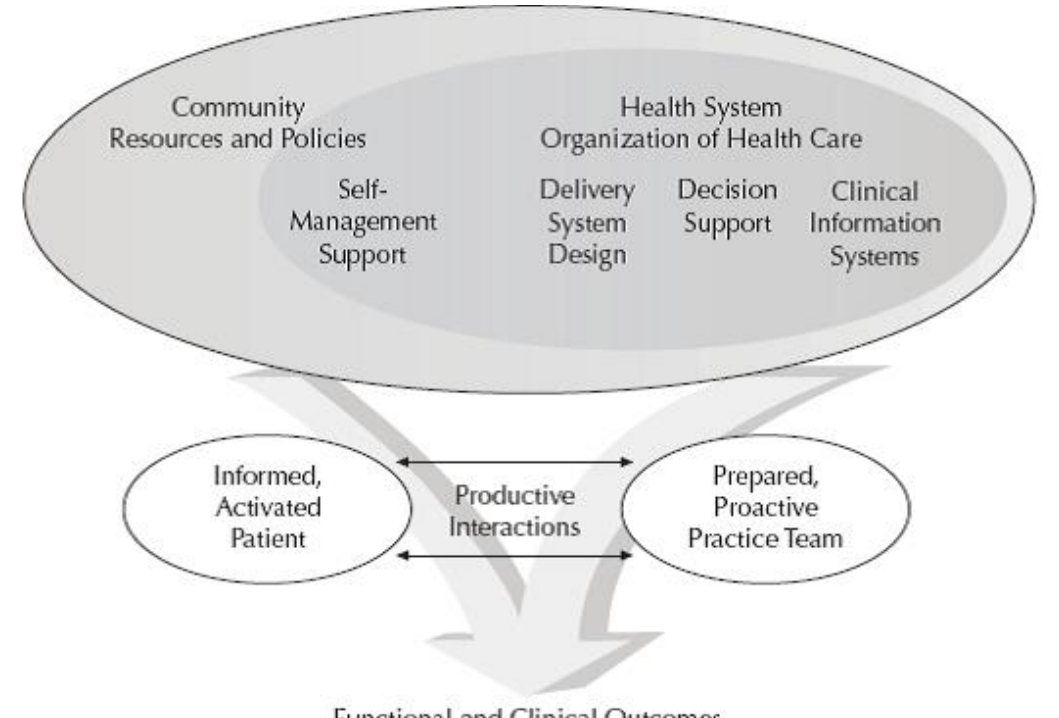
Figure 1. The Chronic Care Model. (Reprinted with permission from American College of